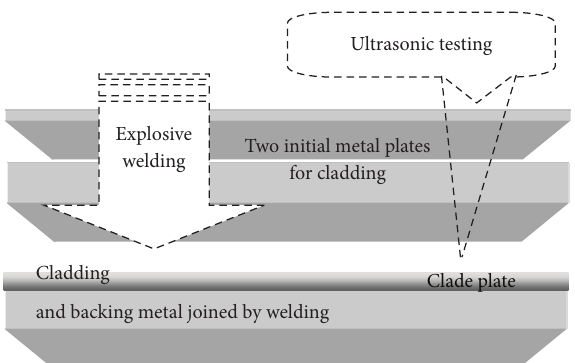
Figure 1: Ultrasonic testing used for initial metal plates before cladding and clad plate after explosive welding.